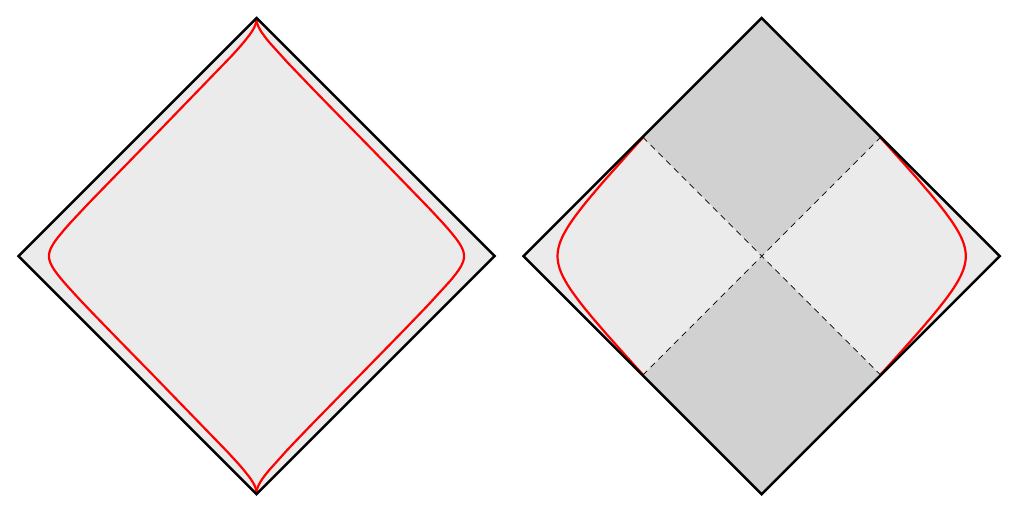
Figure 3 . Flat space boundary particles in Lorentzian signature. On the right, we have the thermal state which is analogous to a Schwarzschild black hole. On the left, we have the vacuum Minkowski state which is similar to the global AdS 2 solution of JT gravity and should be interpreted as an eternal traversable wormhole